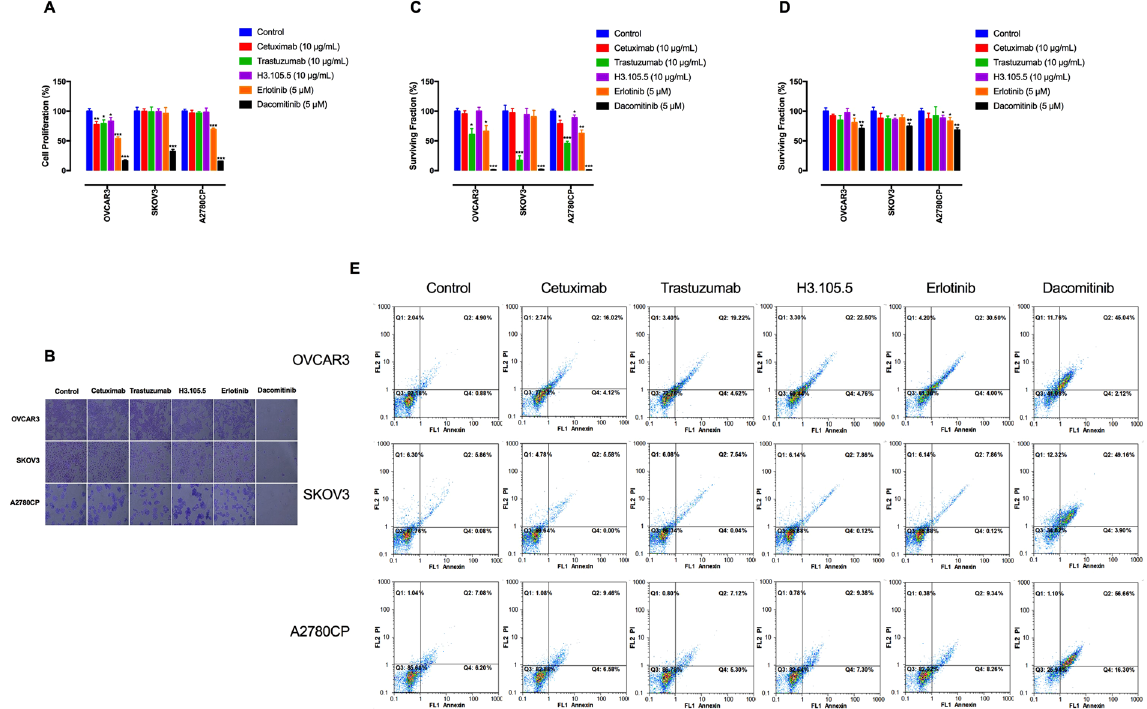
Figure 3. Dacomitinib inhibits cell growth and induces apoptosis. ( A ) The effects of the ErbB inhibitors on cell proliferation were estimated by MTT assay after 48 h of treatment. ( B ) The effects of the anti-ErbB agents on cell viability were demonstrated by crystal violet staining. The cells were treated with the ErbB inhibitors for 48 h, then stained with crystal violet and imaged by an inverted microscope (images acquired at 10x magnification). ( C ) Clonogenic assay was conducted to evaluate the effects of the ErbB inhibitors on clonal proliferation. ( D ) Anoikis resistance assay was performed with cell culture on poly-HEMA–coated culture dishes for 48 h and the proportion of viable cells was measured by MTT assay. ( E ) The effects of the anti-ErbB agents on induction of apoptosis were determined by annexin V staining. Annexin V-positive cells are considered early apoptotic, whereas PI uptake indicates necrosis. Cells positive for both stains are considered late apoptotic. The graphs are representative of three independent experiments with similar outcomes. Data shown represent the mean ± SD from three independent experiments, each performed in triplicate. Statistically significant values of * p < 0.05, ** p < 0.01, and *** p < 0.001 were determined compared with the